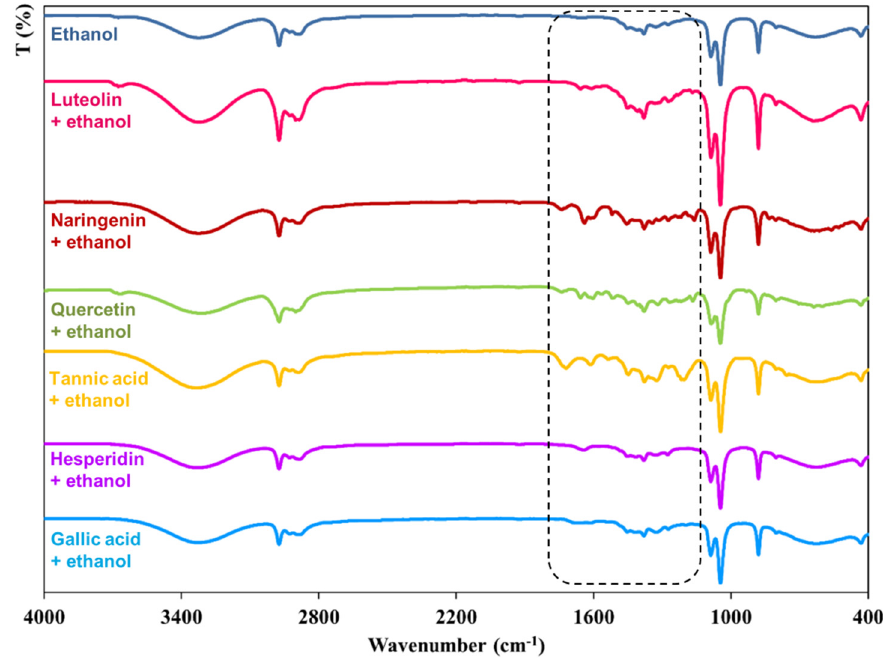
Figure 1. FTIR–ATR spectra of luteolin, naringenin, quercetin, tannic acid, hesperidin and gallic acid in ethanol.